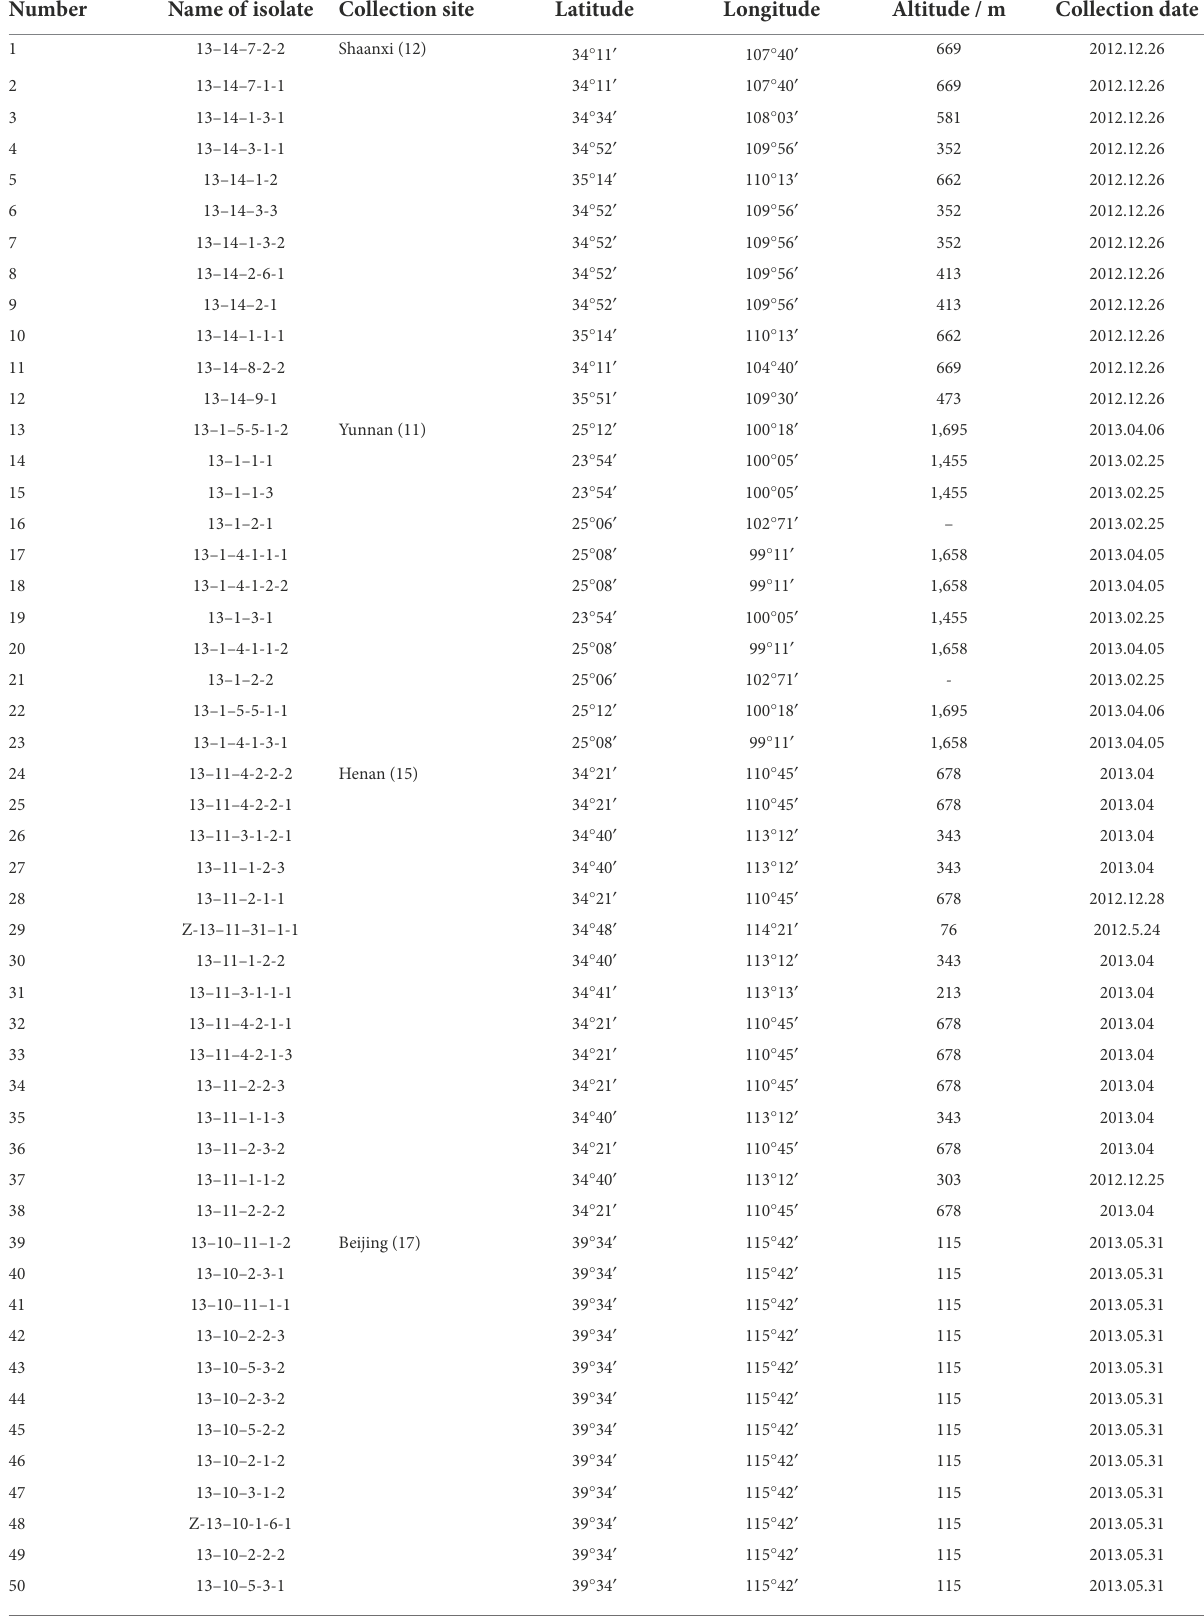
TABLE 1 Information of Blumeria graminis f. sp . tritici isolates used in this